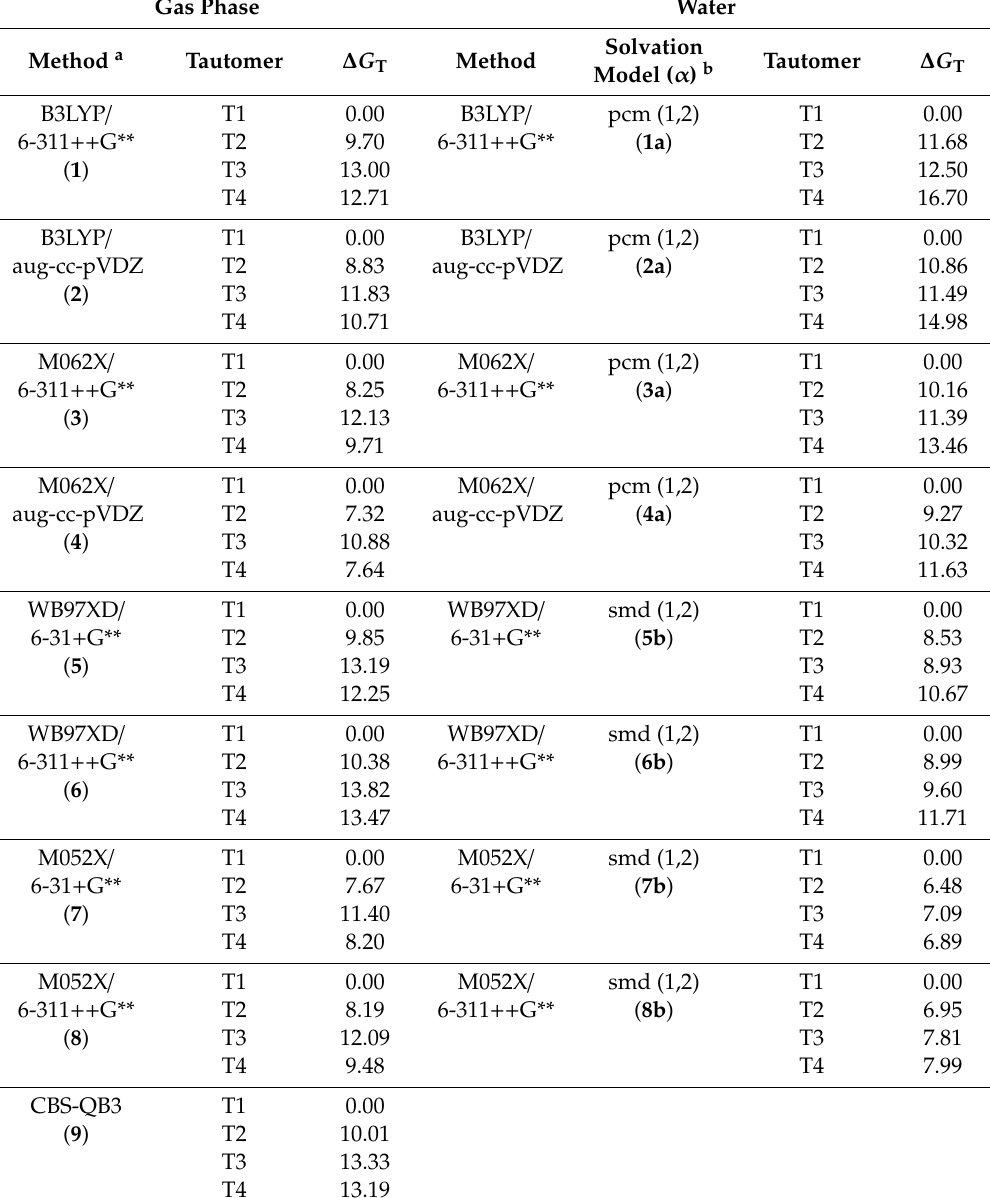
Table 1. Calculated relative energies for the T1–T4 tautomeric forms of 5FU ( ∆ G T , kcal / mol) in the gas phase and in